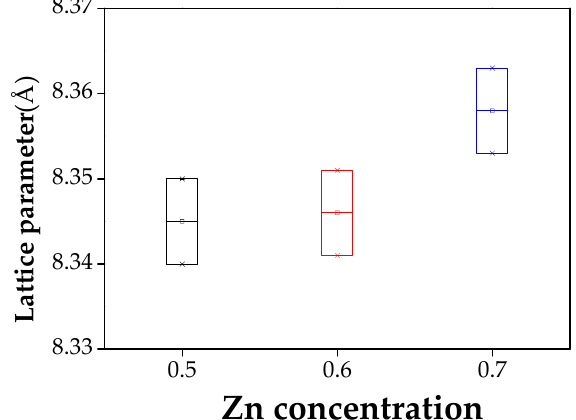
Figure 3. ( a – c ) X-ray diffraction patterns of Ni 1 − x Zn x Fe 2 O 4 (x = 0.3, 0.4, 0.5) nanoparticles of the synthesized samples: ( a ) x = 0.3, ( b ) x = 0.4, and ( c ) x = 0.5.